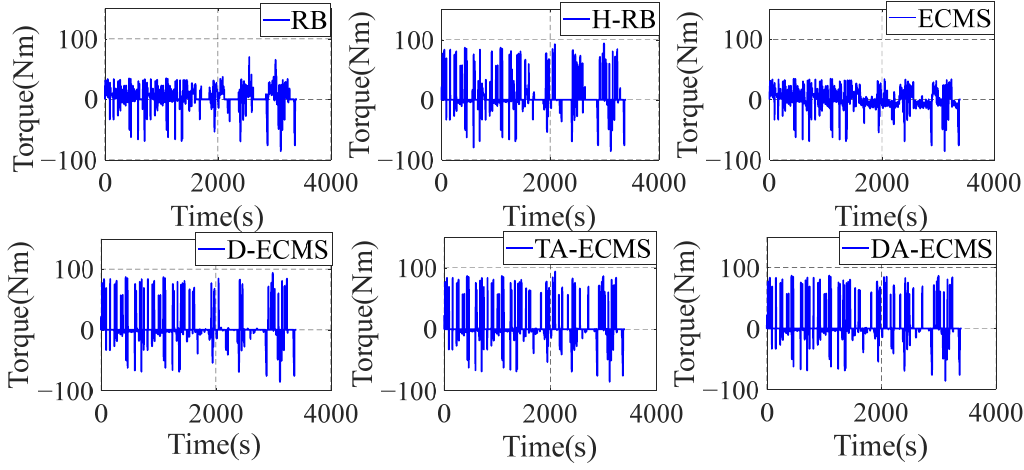
Figure 19. Rear motor torque of energy management strategies.